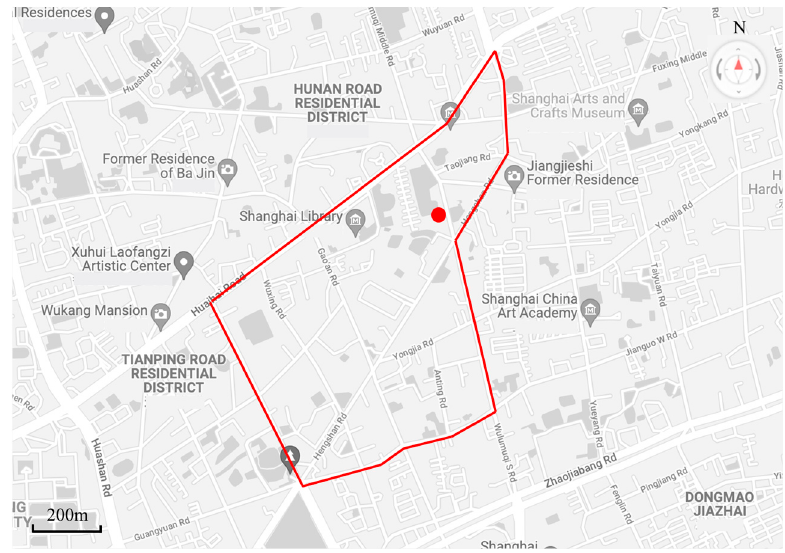
Figure 1. Study area and POI location.